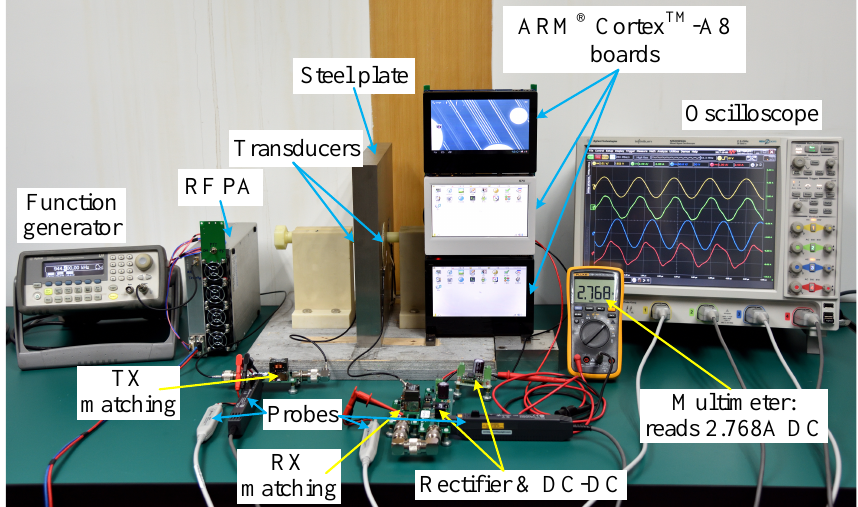
Figure 15. Practical setup of the UTMWPT